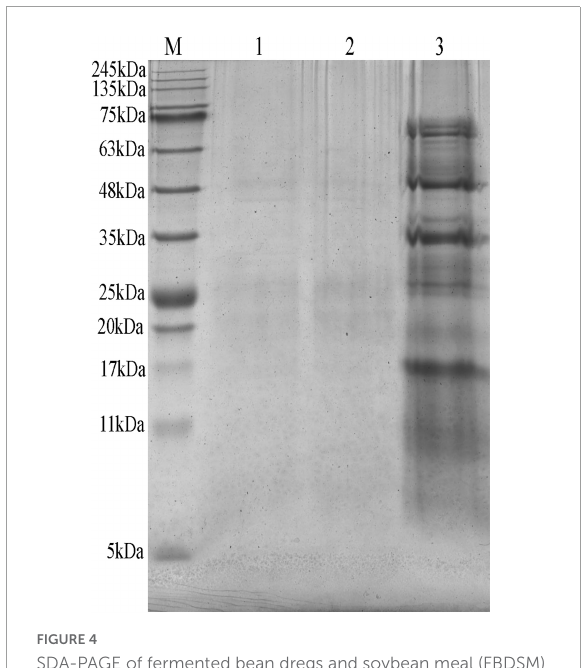
FIGURE4 SDA-PAGE of fermented bean dregs and soybean meal (FBDSM) and mineral element fermentation complexes (MEFC) proteins. M: protein molecular weight markers (5 ∼ 245kDa); 1: FBDSM; 2: MEFC; 3: raw materials.